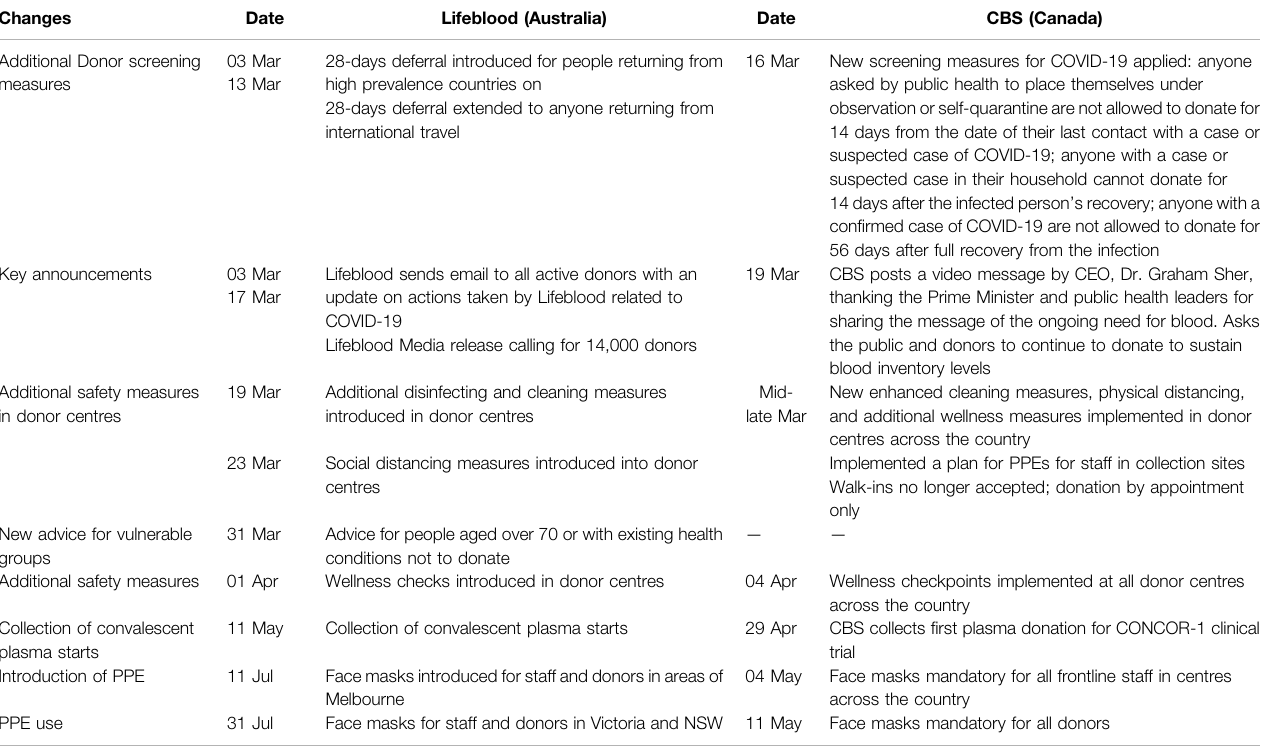
TABLE 2 | Key operational changes and announcements made by Lifeblood and